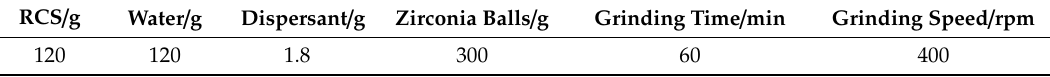
Table 2. Wet grinding parameters for the preparation of wet-ground carbide slag (WGCS). RCS /